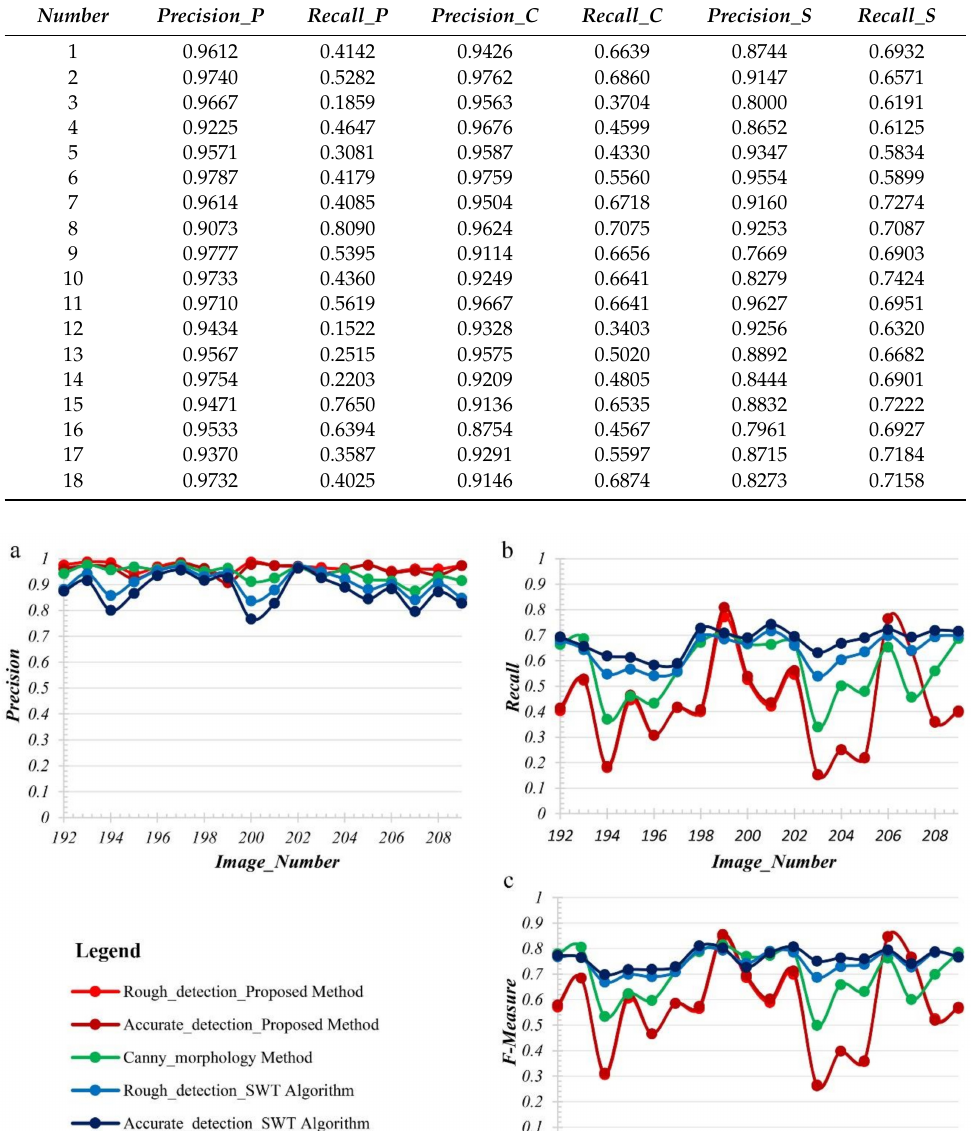
Table 1. Detectionaccuracyforexpansionjointsofalltheimages. Precision_P,Precision_C,andPrecision_C are precision of the proposed method, canny-morphology method, and SWT algorithm respectively. Similarly, Recall_P, Recall_C, and Recall_C are recall of the proposed method, canny-morphology method, and SWT algorithm respectively.